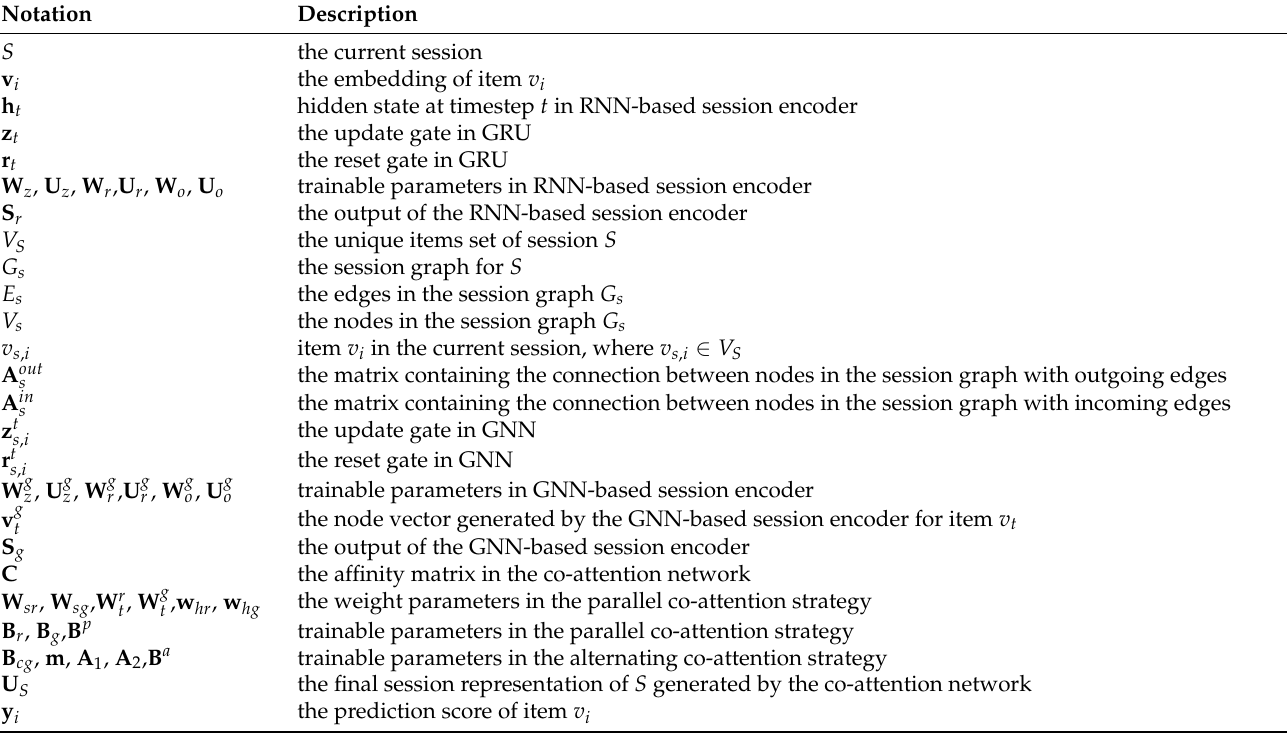
Figure 1. Structure of the CCN-SR model. Table 1. Summary of the main notations used in the